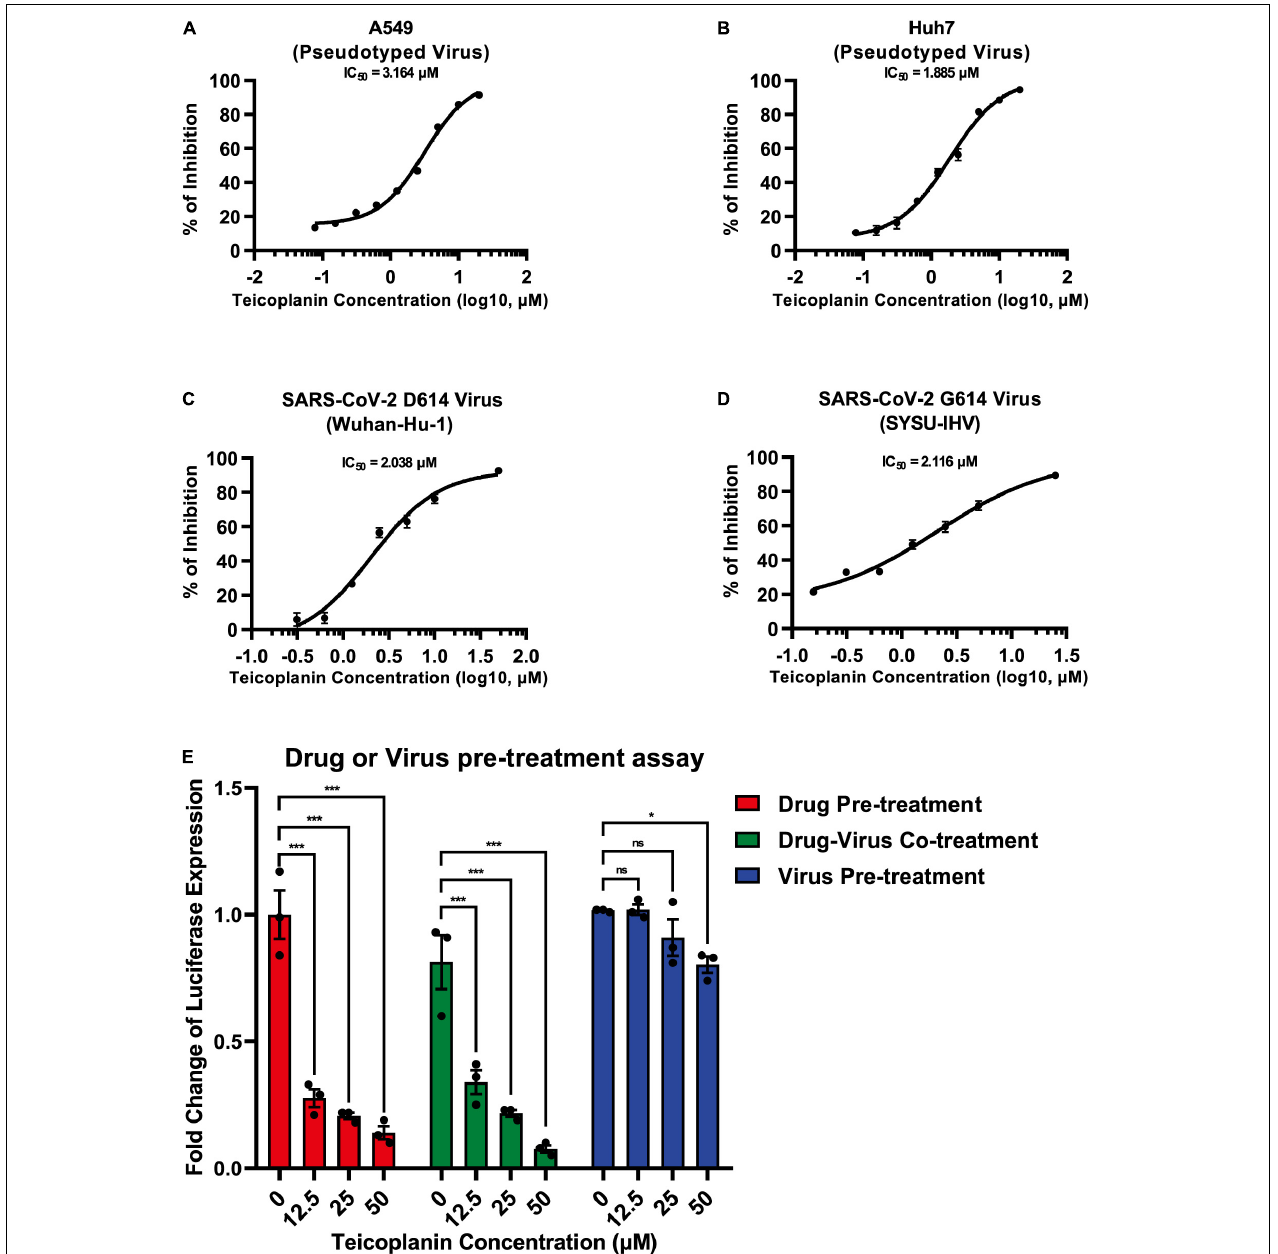
FIGURE 3 | Teicoplanin inhibited the entry of authentic SARS-CoV-2. (A) A549 cells were co-incubated with pseudotyped SARS-CoV-2 S/HIV-1 viruses and twofold serially diluted teicoplanin. The expression of luciferase within cells were measured 48 h post incubation. The IC 50 of teicoplanin against pseudotyped SARS-CoV-2 S/HIV-1 in A549 cells was calculated according to the relative expression of luciferase ( n = 3). (B) The IC 50 of teicoplanin against pseudotyped SARS-CoV-2 S/HIV-1 in Huh7 cells was calculated as in (A) ( n = 3). (C) HEK293T-hACE2 high cells were co-incubated with SARS-CoV-2 D614 (Wuhan-Hu-1) virus and twofold serially diluted teicoplanin. At 48 h post incubation, the supernatant in each group was collected and proceeded to RNA extraction. Viral RNA copies in supernatant were quantified by one-step SARS-CoV-2 RNA detection kit. The IC 50 of teicoplanin against SARS-CoV-2 D614 virus was calculated according to these viral RNA copies within each group ( n = 3). (D) The IC 50 of teicoplanin against SARS-CoV-2 G614 (SYSU-IHV) virus was determined as in (C) ( n = 3). (E) In the first group, HEK293T-hACE2 high cells were pre-treated with 0, 12.5, 25, and 50 µ M teicoplanin, respectively. Four hours later, cells were infected with pseudotyped SARS-CoV-2 S/HIV-1 virus. In the second group, cells were co-treated with different concentrations of teicoplanin and pseudotyped SARS-CoV-2 S/HIV-1 virus simultaneously. In the third group, cells were pre-infected with pseudotyped SARS-CoV-2 S/HIV-1 virus. Four hours post infection, cells were treated with different concentrations of teicoplanin. The amounts of luciferase within cells were quantified 48 h post infection. The fold changes of luciferase expression within each sample were calculated by normalizing to those in cells treated with 0 µ M teicoplanin ( n = 3). Data in (A–D) represented as mean ± SEM in triplicate. Inhibition curves in (A–D) were generated by log (inhibitor) vs. response non-linear fit. P -values in (E) were calculated by two-way ANOVA with Dunnett’s multiple comparisons test which compared the mean of each group with the mean of the control group. ns p ≥ 0.05, * p < 0.05, *** p < 0.001.